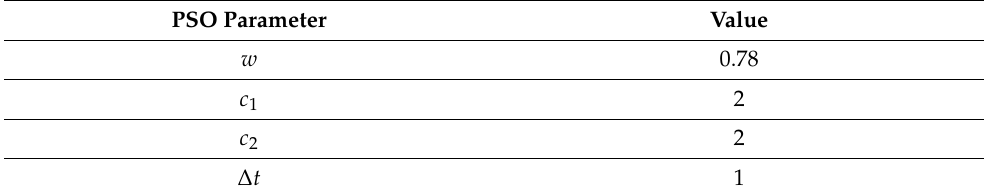
Table 4. Particle swarm optimization (PSO) parameters used in the present